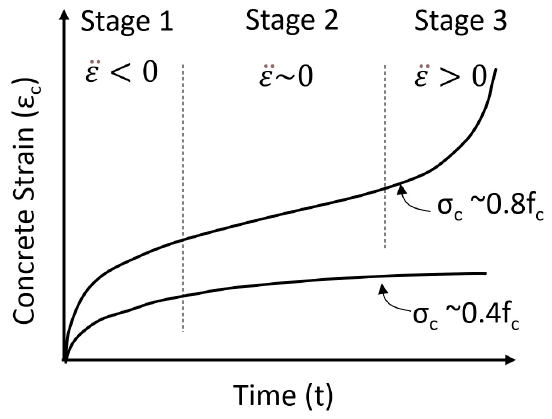
Figure 1. Evolution of creep strains with time (primary, secondary, and tertiary stages of creep).